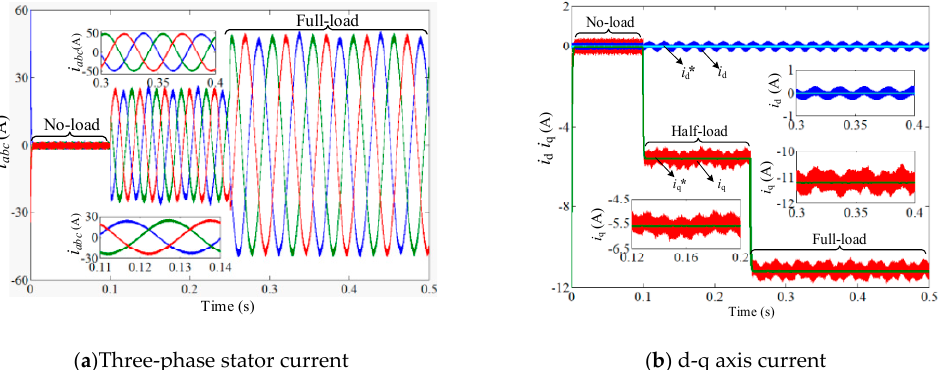
Figure 12. Current waveforms of a three-phase PMSG unit with the PI controller. Energies 2018 , 10 , x FOR PEER REVIEW